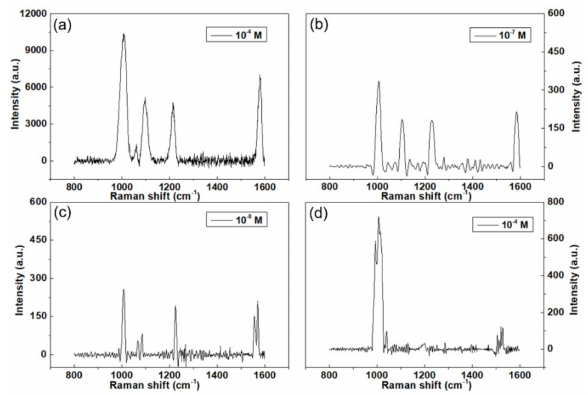
Figure 5. ( a – c ) Concentration-dependent (10 − 4 M, 10 − 7 M and 10 − 8 M) SERS spectra of 4-Mpy adsorbed on the Au@Cu NAs with the galvanic reaction time of 3 min. ( d ) SERS spectrum of 10 − 4 M 4-Mpy absorbed on Cu NAs.